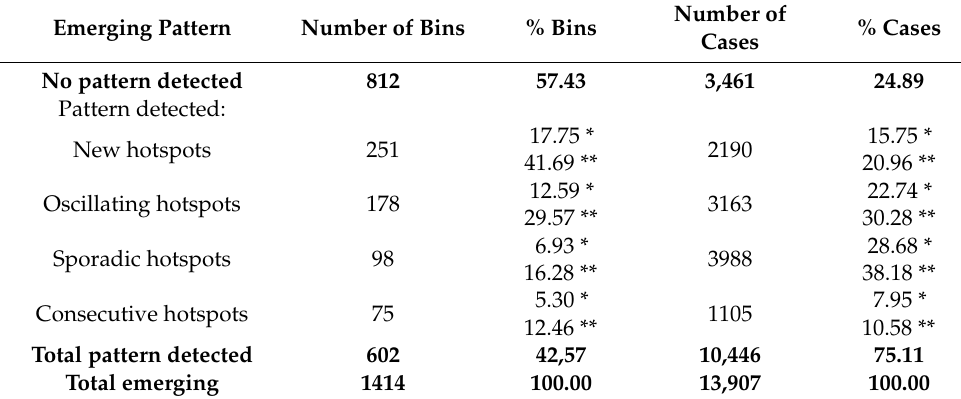
Table 3. Emerging hotspot statistics: bins and number of COVID-19 cases. Emerging Pattern Number of Bins % Bins